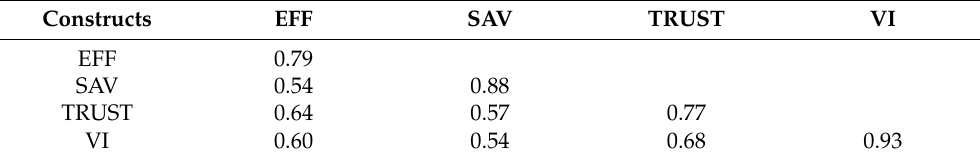
Table 3. The divergent validity matrix of the research model using the Fornell–Larker